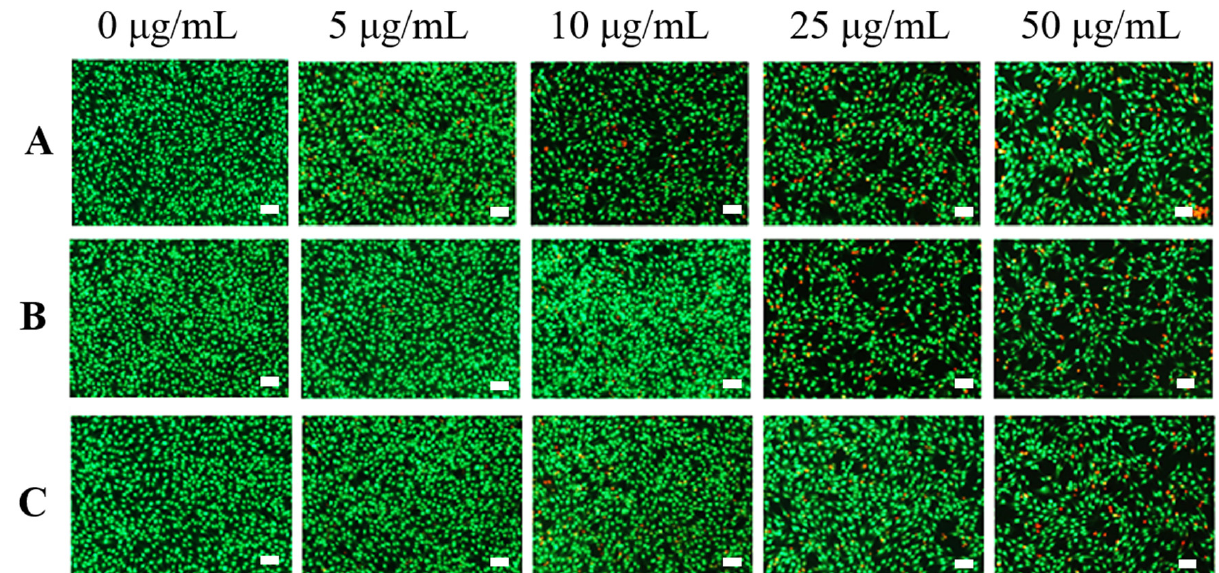
Figure 6. AO/EB staining assay of MC3T3-E1 cells cultured with various samples CNT ( A ), CNT@PDA ( B ), CNT@ALG ( C ) in different concentration. (100× magnification, Bar = 100 μ m).